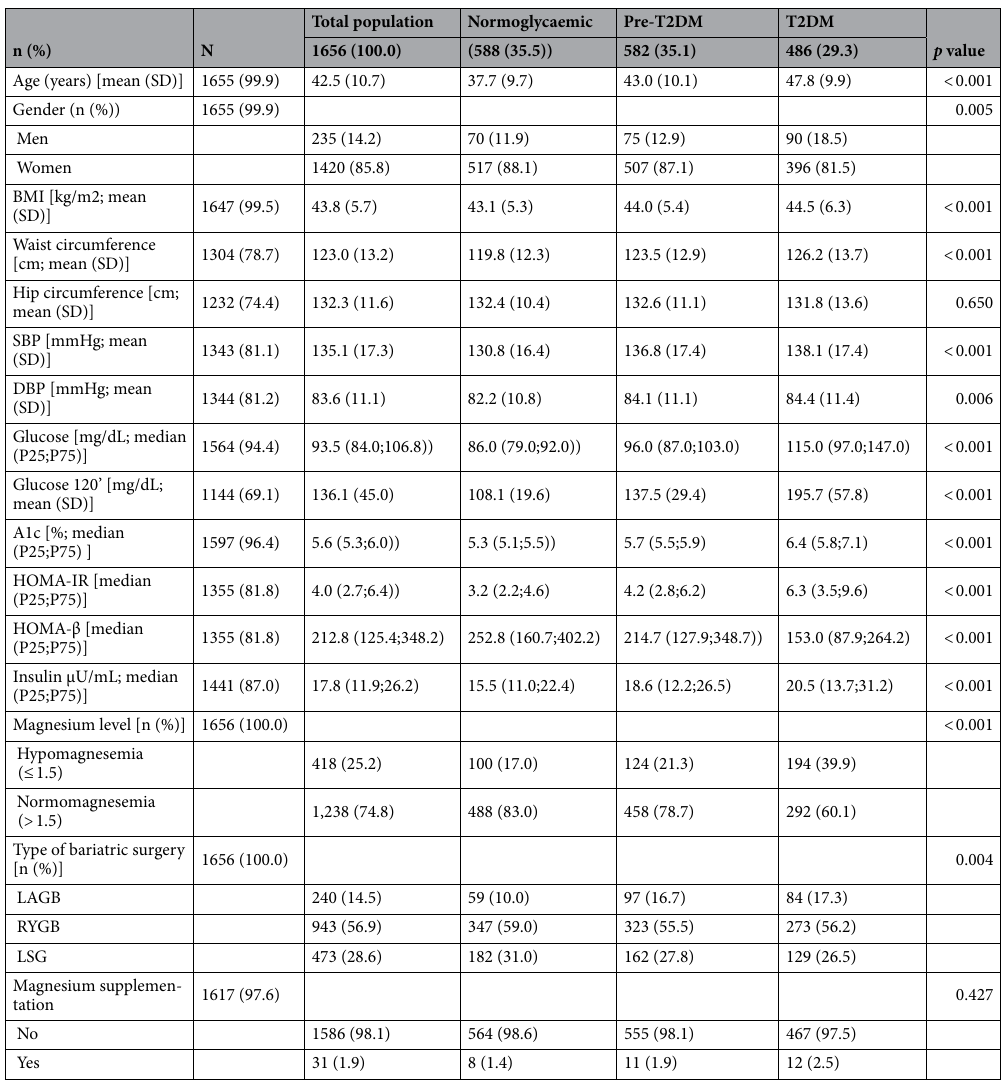
Table 1. Preoperative characteristics of the studied sample. A1c: glycated haemoglobin; BMI: body mass index; DBP: diastolic blood pressure; IQR, interquartile range; HOMA-IR: homeostasis model assessment of insulin resistance; HOMA-β: homeostasis model assessment of β-cell function; LAGB: laparoscopic gastric band; LSG: sleeve gastrectomy; P25, percentile 25; P75; percentile 75; RYGB: Roux-en-Y gastric bypass, SBP, systolic blood pressure; SD, standard deviation, T2DM, Type 2 Diabetes